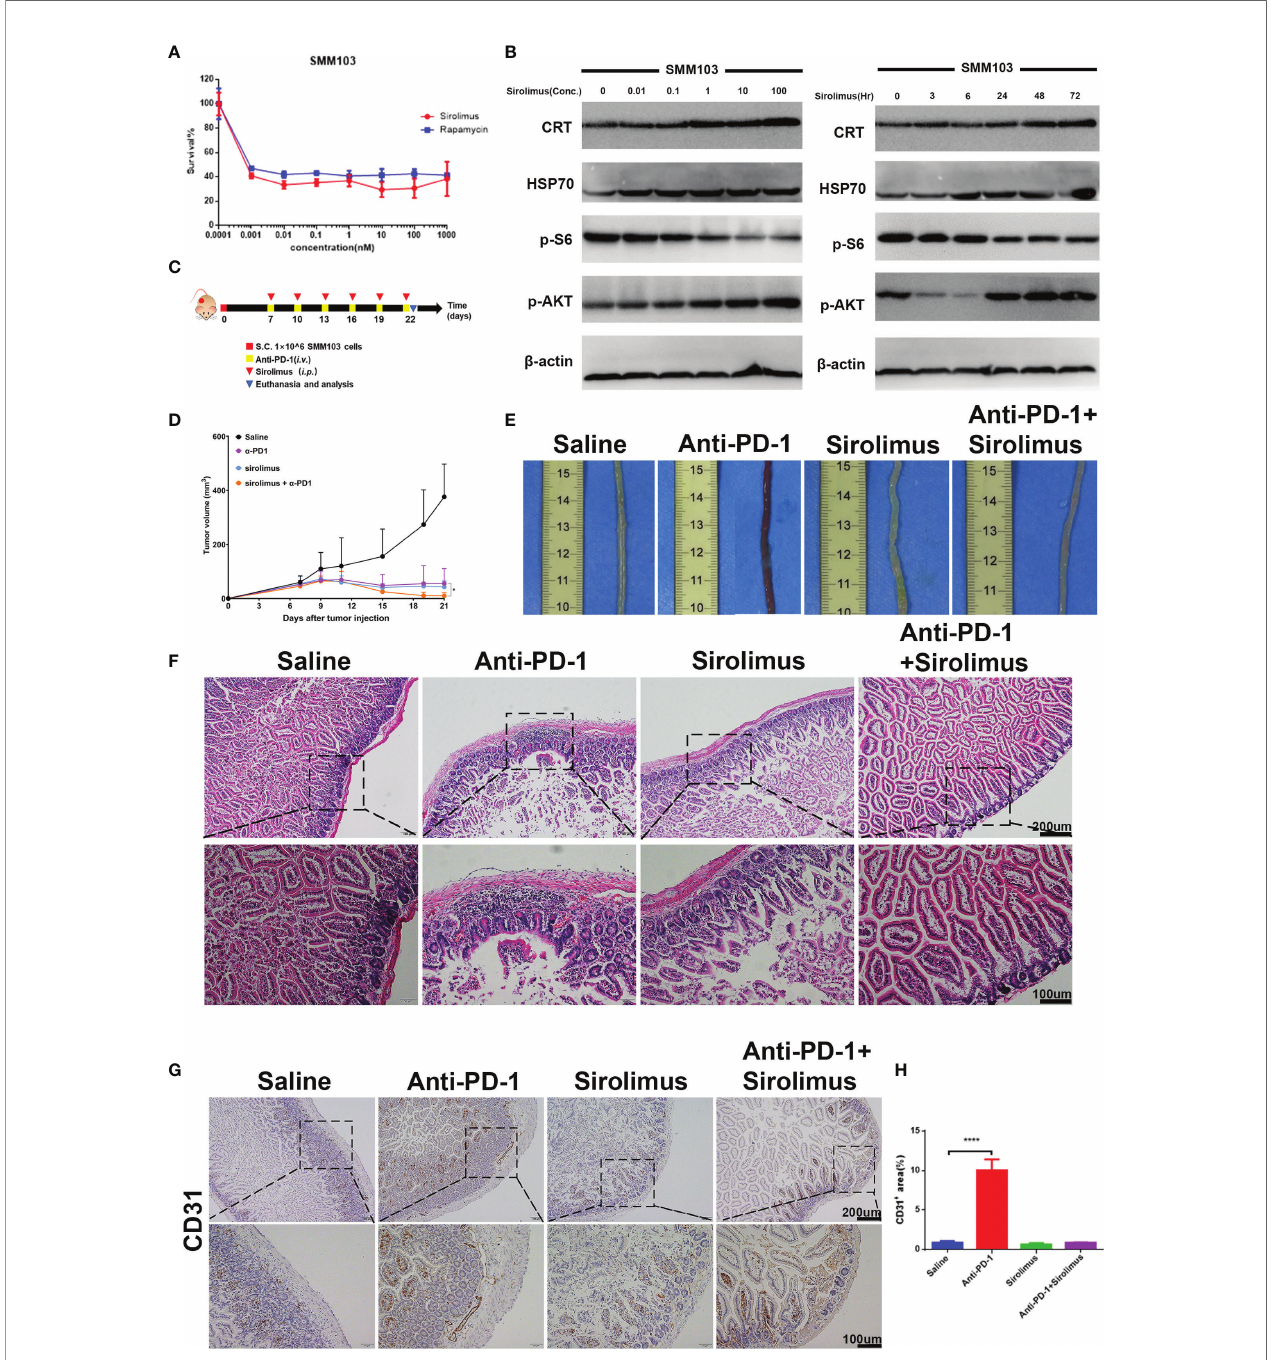
FIGURE 4 | Sirolimus inhibited tumor cells growth and induced anti-in fl ammatory effects in vivo . (A) Three-day MTT survival assays of SMM103 melanoma cell line in response to sirolimus and rapamycin (as standard, all in nM). Results were expressed as mean ± SD (n=5). Data normalized to DMSO-treated controls. (B) Western Blot analysis of ICD-associated proteins, phosphor-AKT and phosphor-S6 Ribosomal Protein in SMM103 cell line in response to increasing concentrations of Sirolimus (72 h) (left). Western Blot analysis of ICD-associated proteins, phosphor-AKT, phosphor-S6 Ribosomal Protein in SMM103 cell line in response to sirolimus (100 nM) at indicated time points (3, 6, 24, 48, 72 h). (C) Immune competent C57BL/6 mice were subcutaneously inoculated with 1×10 6 SMM103 melanoma cells on day 0. When tumor volume achieved ≈ 80 mm 3 , mice were treated with saline, anti-PD-1, sirolimus, anti-PD-1 plus sirolimus, respectively. Details of treatment are provided in the Methods section. (D) The average tumor growth curves of mice from each group. (E) Representative intestine from each group after euthanizing the mice on day 22. (F) H&E staining of FFPE colon sections from each group. Scale bar 200 m m. (G) CD31 IHC staining of FFPE colon sections from each group. Scale bar 200 m m. (H) Quantitative results of CD31 positive area. Data was expressed as mean ± SD (n=4), ****p <